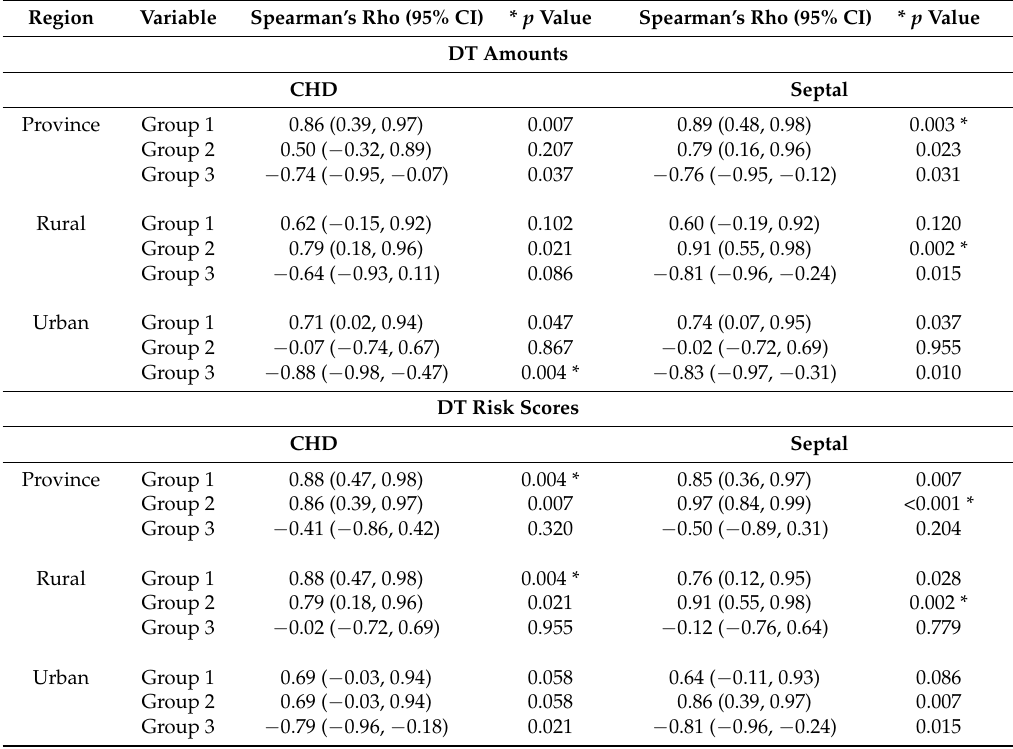
Table 6. Associations of CHD and Septal Defect Rates with DT